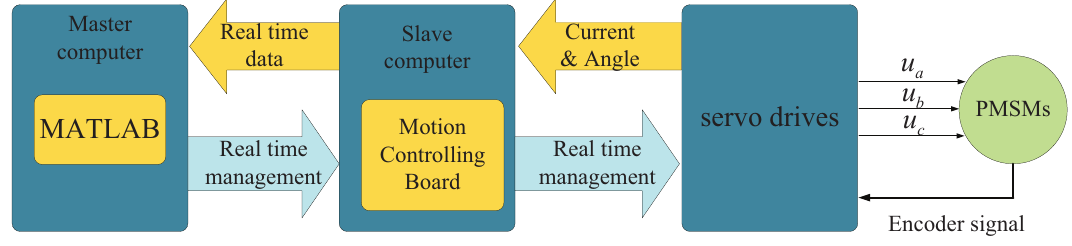
Figure 8. Experiment system